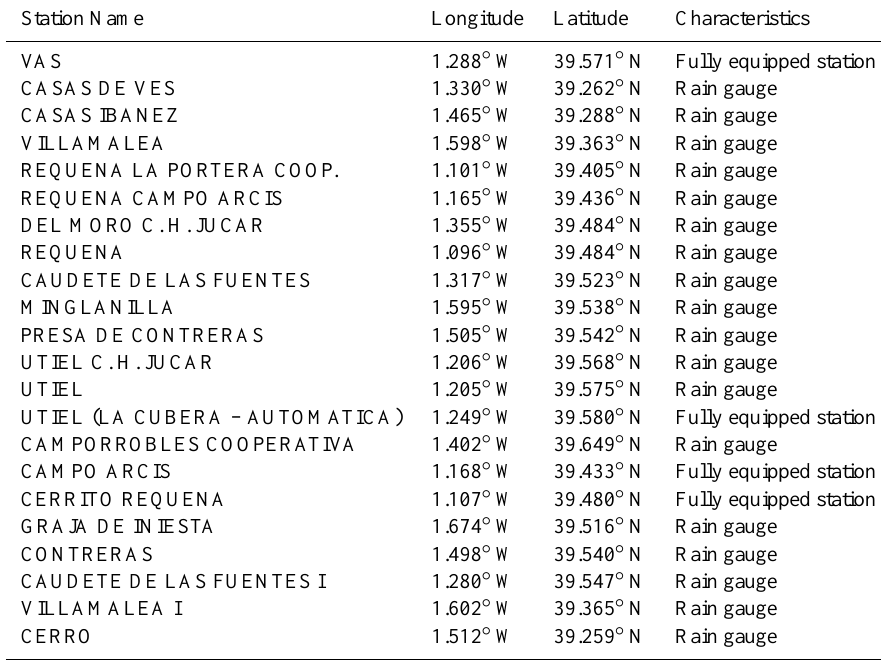
Table 1. Coordinates of the meteorological stations located in the 50 × 50km 2